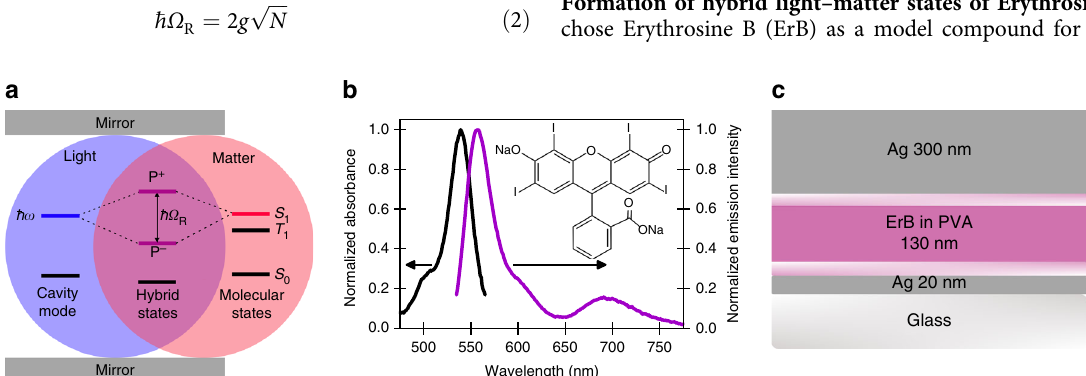
Fig. 1 Molecular system for realizing strong light – matter coupling. a Jablonski diagram presenting strong coupling of a molecular state ( S 1 ) with a cavity mode ( ħ ω ) that has the same energy and leads to the formation of two new hybrid light – matter states, P + and P − , which are separated in energy by the Rabi splitting ( ħ Ω R ). b Absorption (black line) and emission (purple line) spectra of 1 wt% ErB in a PVA matrix deposited on a glass substrate. Inset shows the chemical structure of ErB. c Structure of the non-transparent Fabry – Pérot cavity, where two Ag mirrors sandwich a PVA fi lm containing ErB. PMMA 10 nm fi lms, deposited between the mirror and chromophore layer, were used to prevent direct contact between ErB and the Ag